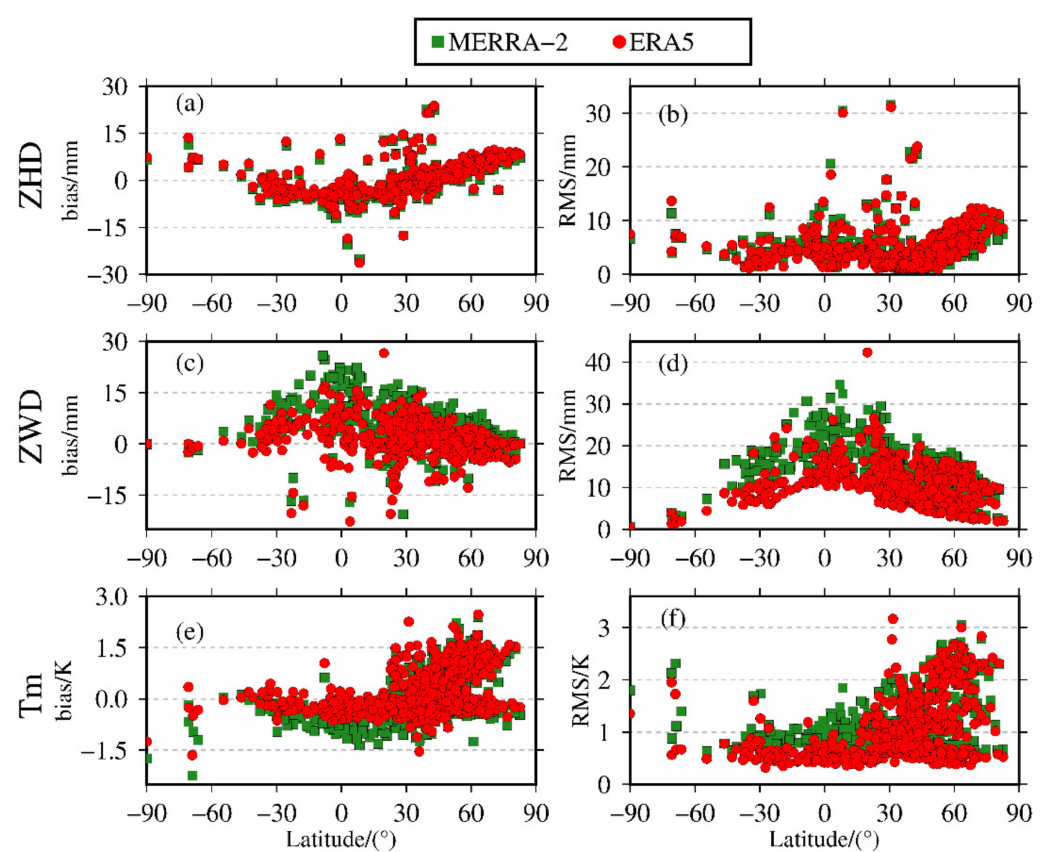
Figure 10. Variations with latitudes of the annual average ( a , c , e ) bias and ( b , d , f ) RMS values of ZHD, ZWD, and T m .